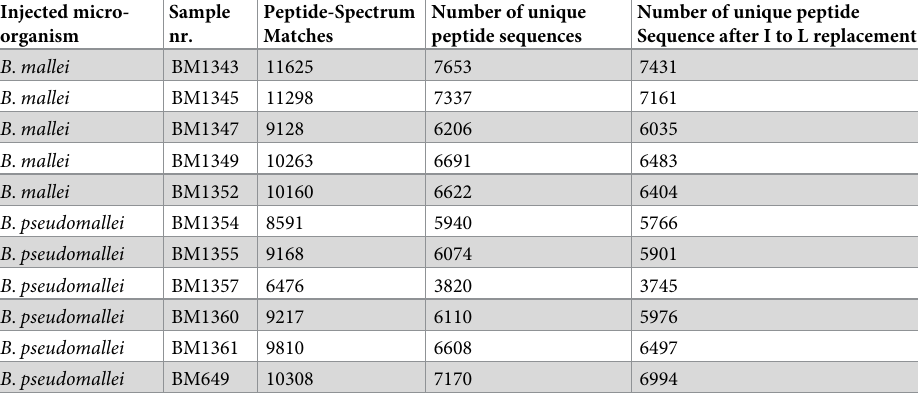
Table 6. Overview of the results of the number of identified peptides using the BPC-DB. Injected micro- Sample organism nr.